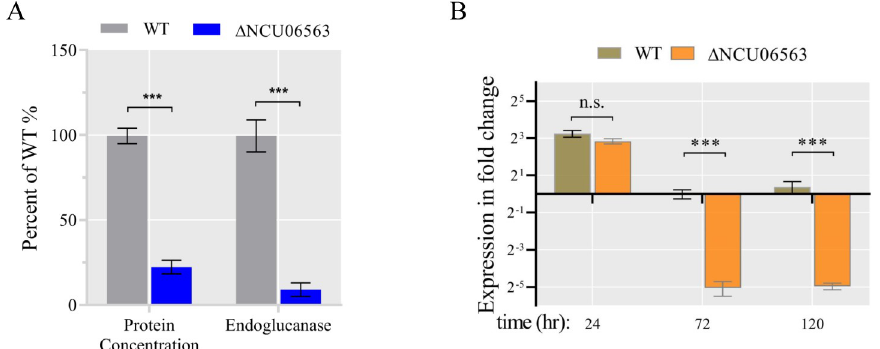
Fig 8. Phenotype of WT and Δ NCU06563 strains when grown on Avicel medium. Conidia from Δ NCU06563 and wild-type (WT) strains were separately inoculated into Avicel medium and batch-cultured for 5 days. (A) Deletion of NCU06563 results in serious defects in cellulase production. Total extracellular protein concentration and endoglucanase activity of culture broth were measured and are expressed as a percentage of those in WT. (B) Relative transcript levels of major cellulase gene ( cbh-1 ) in hypo-producing mutant Δ NCU06563 versus WT after 1–5 days growth on Avicel. After growth of conidia in Avicel for 24, 72, or 120 h, transcript abundance of cbh-1 was evaluated by RT-qPCR. Values represent means of at least three biological replicates, error bars show standard deviation. Statistical significance was determined by two-tailed Student’s t -test ( ��� , P < 0.001). Data are normalized against tested gene’s transcript level in WT strain at 72 h. Actin (NCU04173) transcript level was used as endogenous control in all samples. Values represent means of at least three biological replicates; error bars show standard deviation.